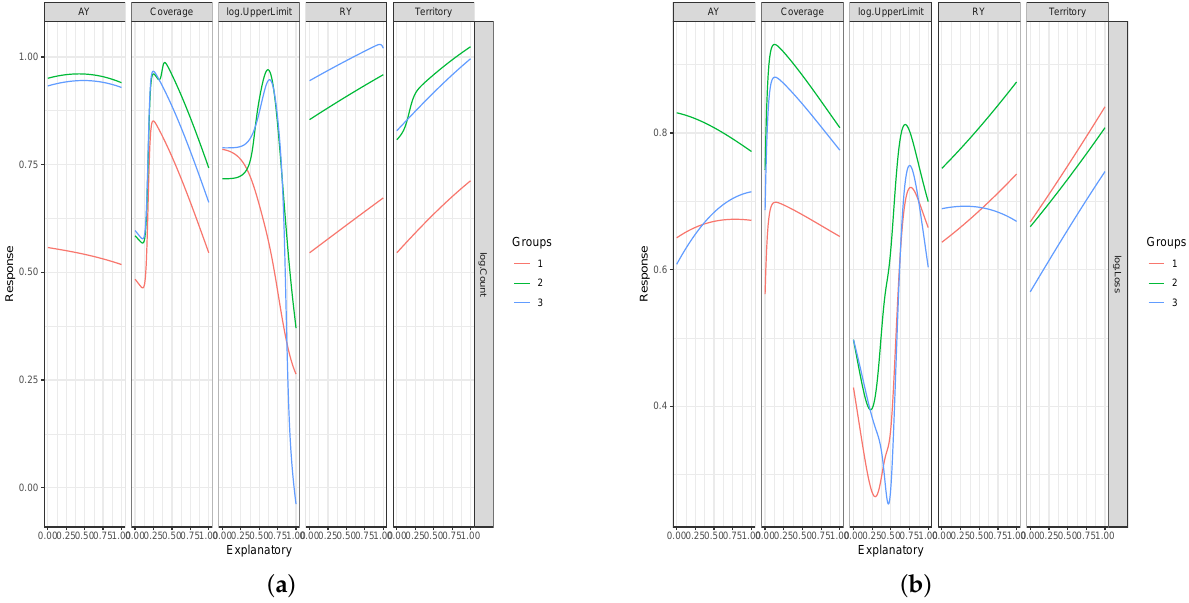
Figure 1. Sensitivity analysis of ANN models using the Lek profile method to evaluate the effect of each risk factor. The figure sorts unevaluated risk factors into three groups. ( a ) Claim Counts. ( b ) Loss